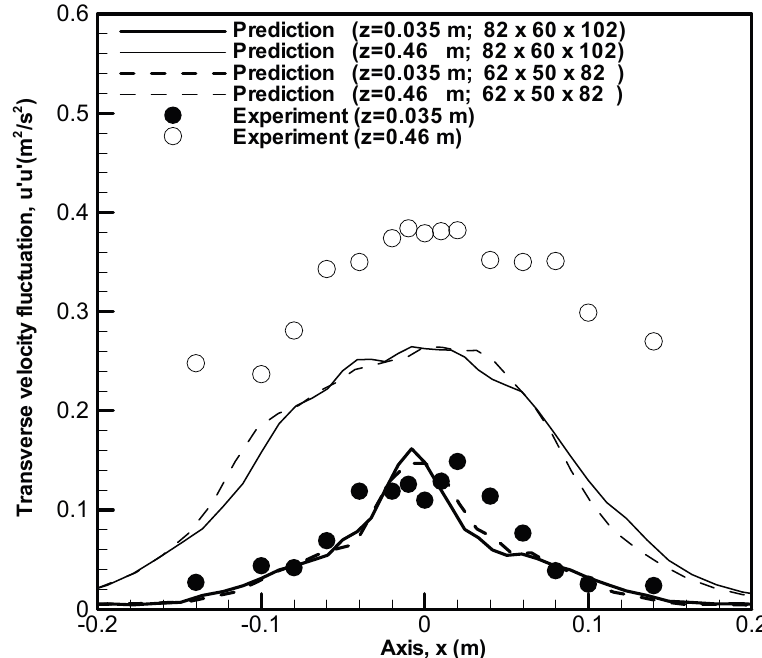
Figure 2. Profiles of the measured and predicted transverse velocity fluctuation, u ′ u ′ , at z = 0.035 and 0.46 m